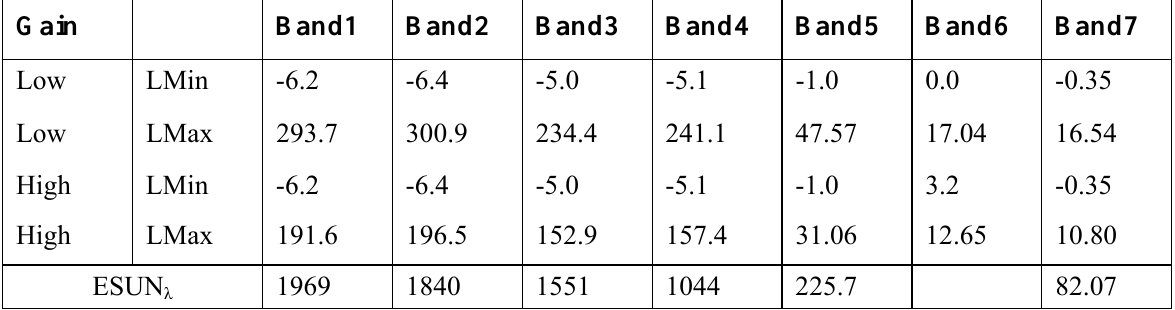
Table 2. Spectral radiances (LMin/LMax) and mean solar exoatmospheric irradiances ) for Landsat-7 ETM+ (ESUN λ